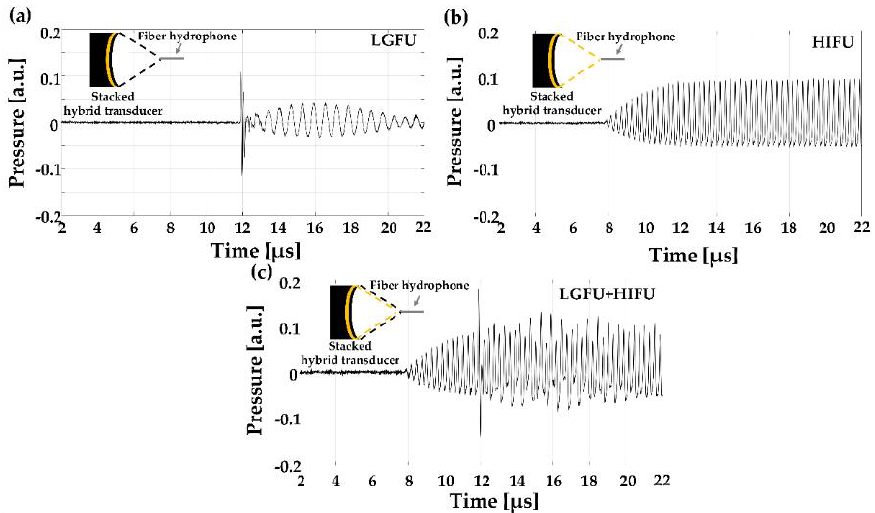
Figure 8. FUS waveforms generated from the stacked hybrid transducer: ( a ) LGFU alone; ( b ) HIFU alone; ( c ) LGFU and HIFU together.